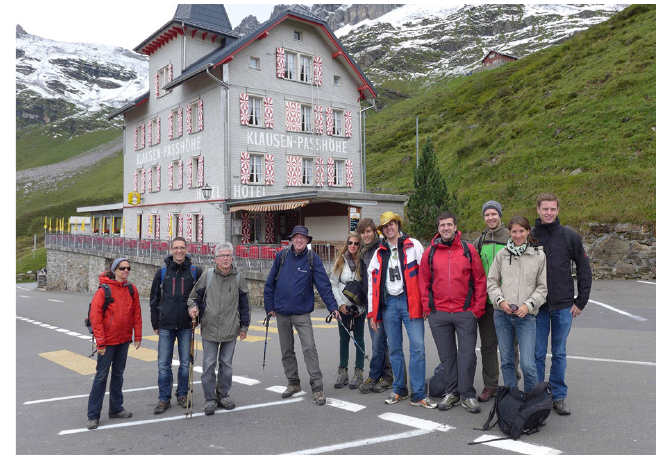
Figure 3: RiskLab excursion 2014 on the Klausenpass